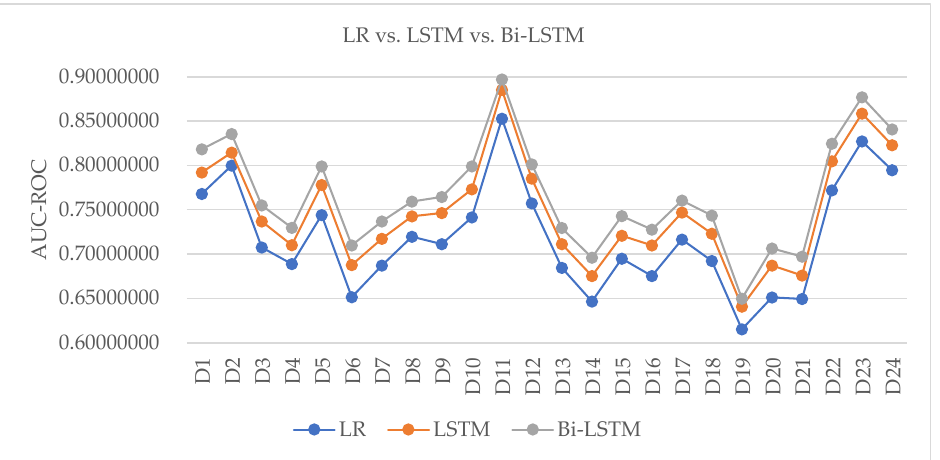
Figure 7. Model comparison: multinomial logistic regression (LR) vs. long short-term memory (LSTM) vs. bi-directional long short-term memory (Bi-LSTM) models.